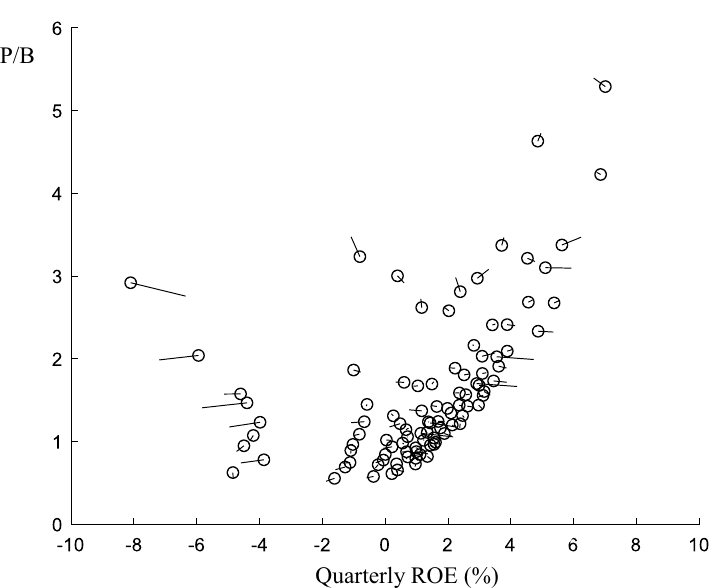
Fig. 5 The ROE and P/B ratio for the subsequent first and second quarter after the portfolios are